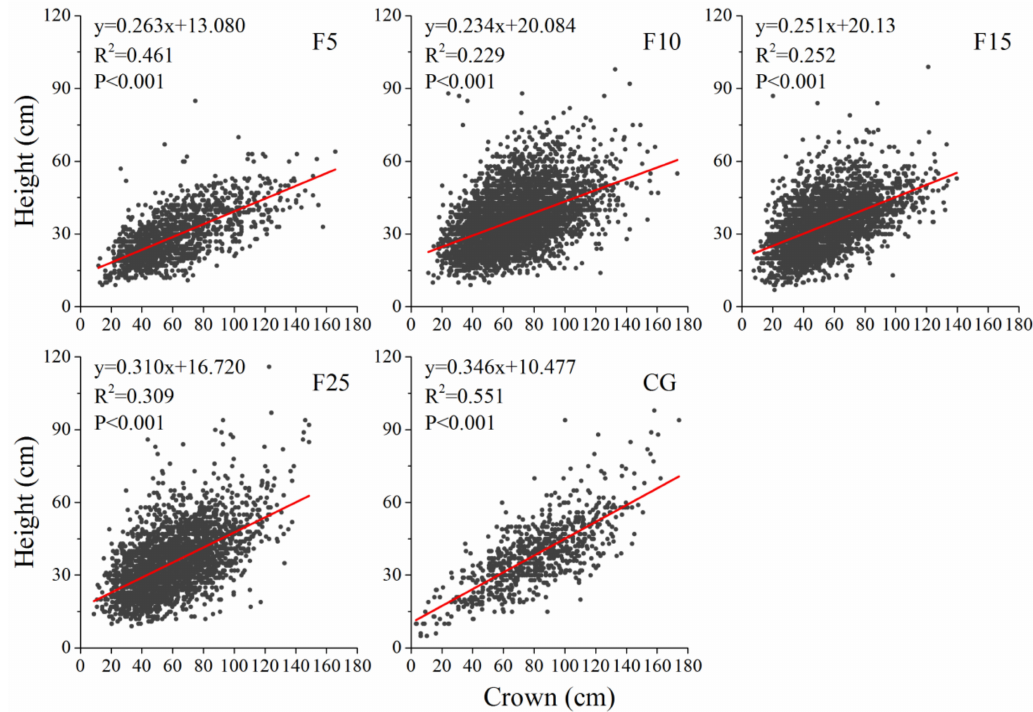
Figure 2. The crown and height allometric model of A. ordosica population in F5 (enclosed 5 years), F10 (enclosed 10 years), F15 (enclosed 15 years), F25 (enclosed 25 years), and CG (continuously grazed) plots.